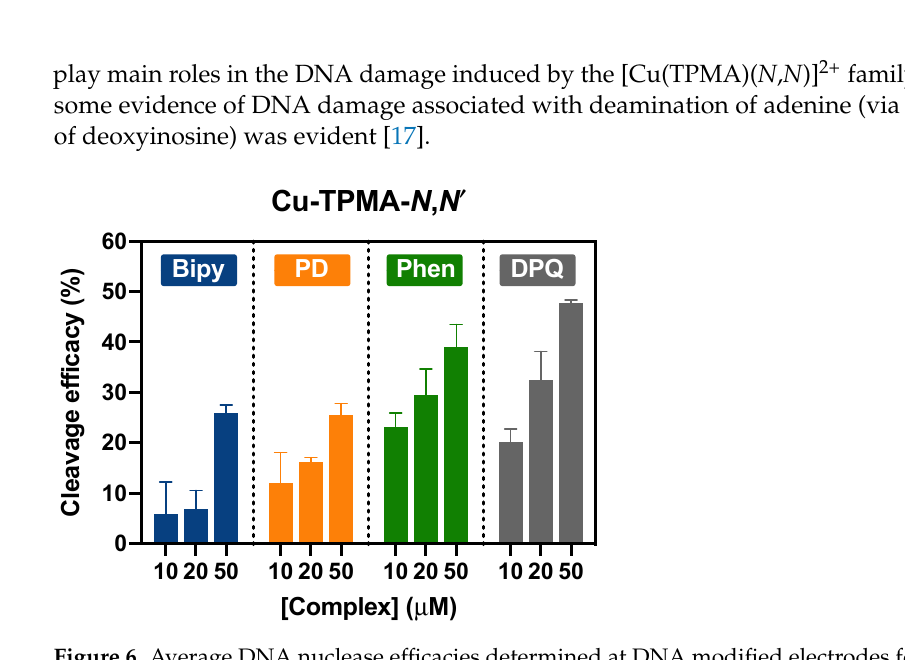
Figure 6. Average DNA nuclease efficacies determined at DNA modified electrodes for the copper complexes in 10, 20, and 50 µ M concentrations; [Cu(TPMA)(bipy)] 2+ (blue bars), [Cu(TPMA)(PD)] 2+ (orange bars), [Cu(TPMA)(phen)] 2+ (green bars), and [Cu(TPMA)(DPQ)] 2+ (grey bars). [Cu(TPMA)] 2+ was found to cause insignificant DNA cleavage, 5.36% (%RSD